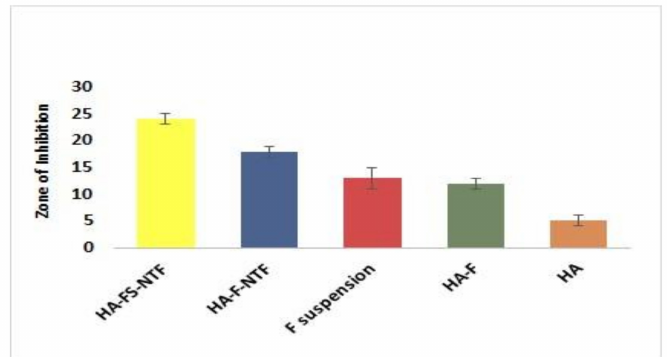
Figure 10. Representation of inhibitory zone diameters (mm) following 48 h of incubation of the agar plates containing C. albicans . Data are expressed as mean ± SD ( n = 3).